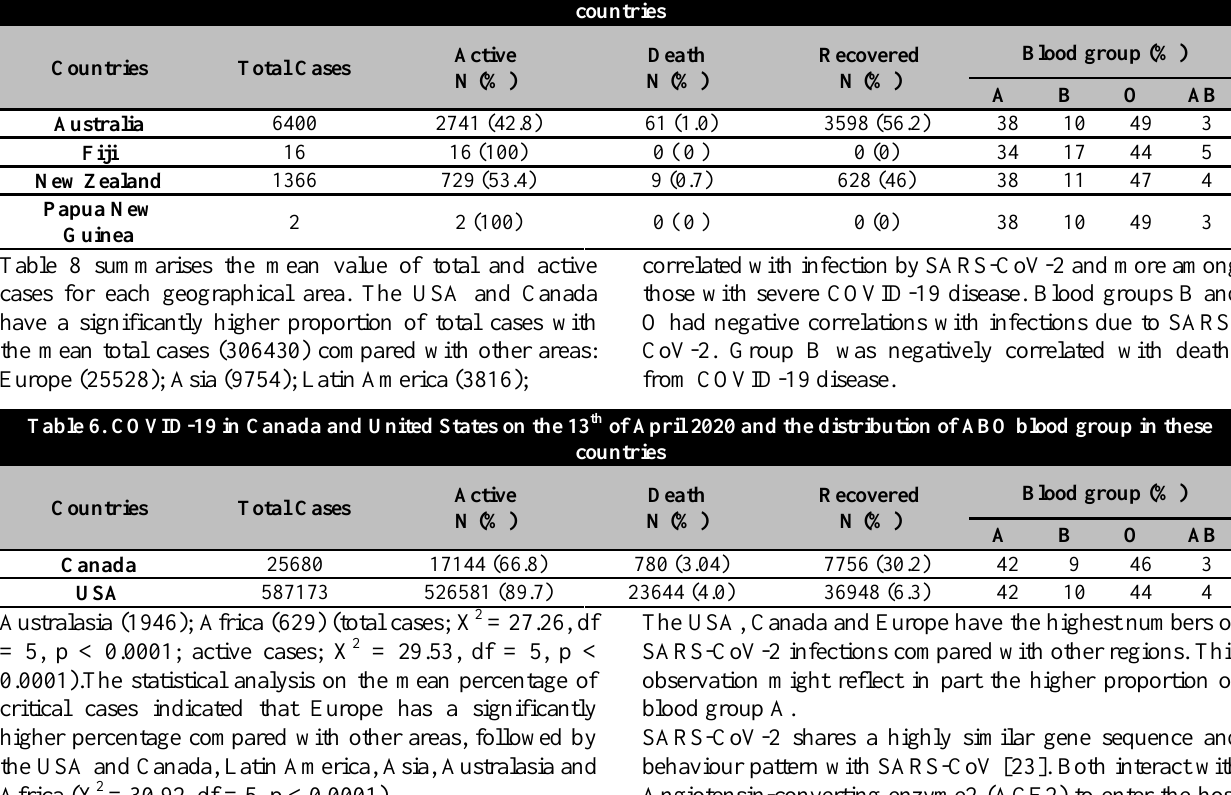
Table 7. Distribution of ABO blood groups among the six geographical regions